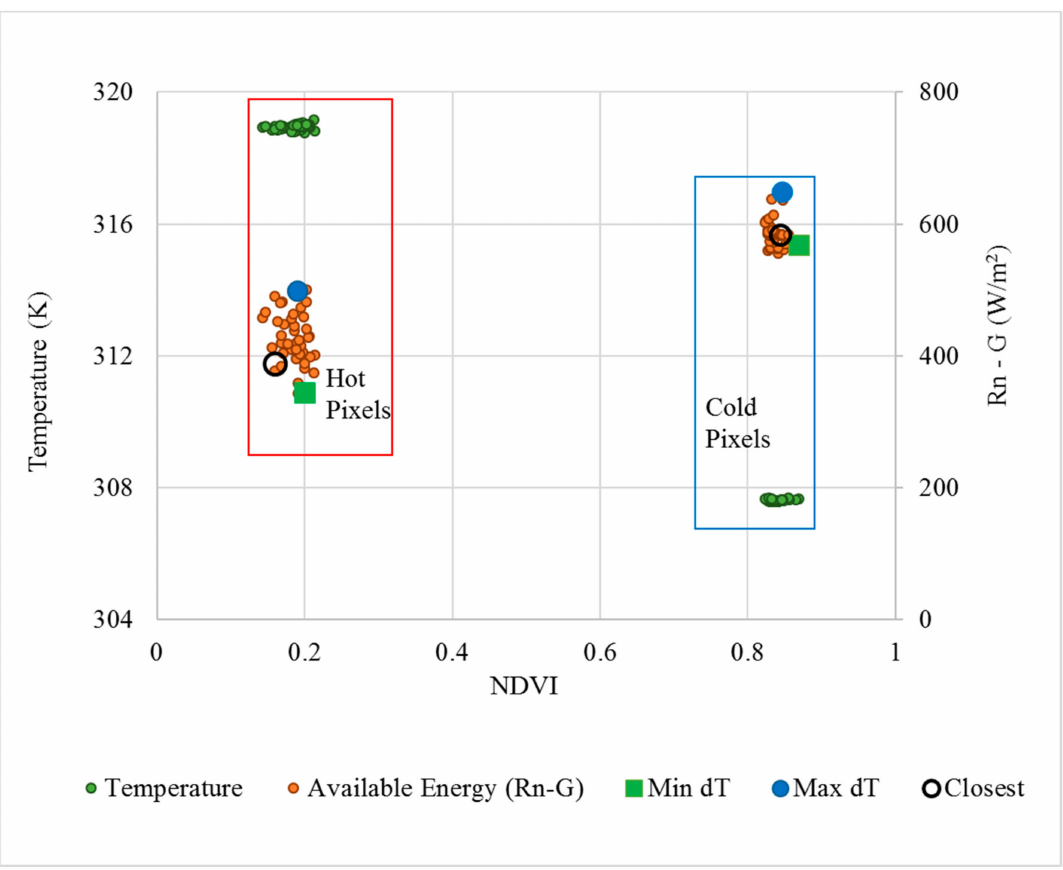
Figure 5. Variability in temperature, NDVI, and available energy within candidate anchor pixels for